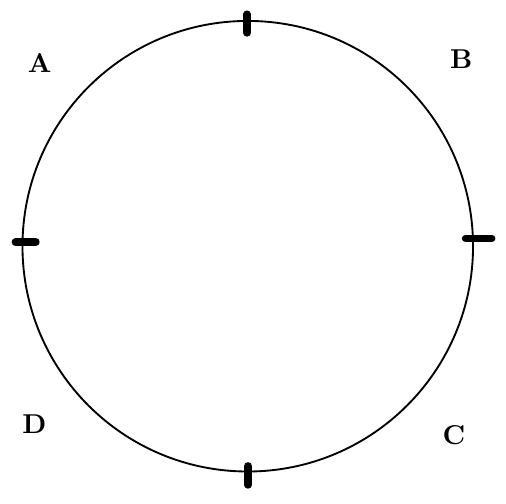
Figure 2 . Division of the boundary into atomic